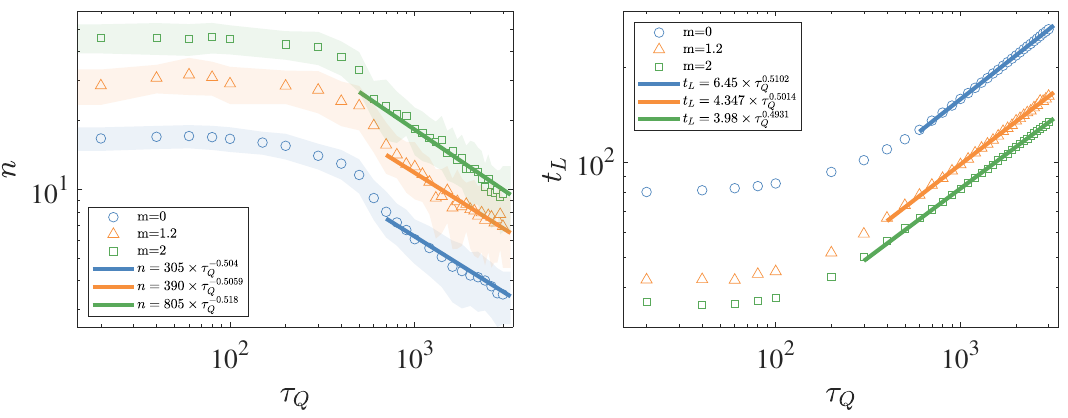
Figure 2 . (Left panel) Double logarithmic relation between vortex number n and quench time τ Q for graviton mass m = (0 , 1 . 2 , 2) . The circles, triangles and squares are the numerical data while the straight lines are the best fitted lines in the slow quench regime (larger τ Q ). The shaded regions represent the standard deviations away from the mean values. For the slow quench, the scaling relations satisfy the KZM scaling laws very well; however, for fast quench (smaller τ Q ), vortex number n is almost constant beyond the scope of KZM. (Right panel) Double logarithmic relation between the lag time t L and quench rate τ Q . For slow quench the relation between t L and τ Q satisfy the KZM scalings very well, while for fast quench t L keeps almost constant. This figure was obtained by running 100 times of simulations for each τ Q and m